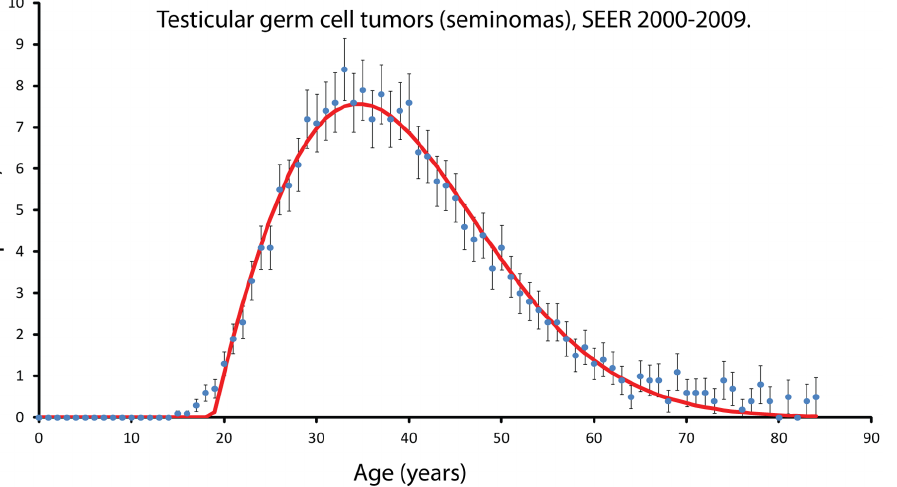
Figure 2. The specific incidence, as recorded by the SEER-17 cancer registries from 2000–2009, for testicular germ cell tumors (seminomas) is shown as a function of age. The points indicate the measured values and the error bars indicate 95 % confidence intervals. The incidence reaches a maximum in the early 30’s and decreases to near zero. The solid line indicates the best fit Weibull distribution. The agreement between the data and the line supports the extreme value model. The area under the line is about 207, which indicates that in a population of 100000 men only about 207 men are susceptible to developing this form of cancer. The actual number of tumors that develop in those 100000 men will be lower than 207 because some men will die before they develop testicular cancer.